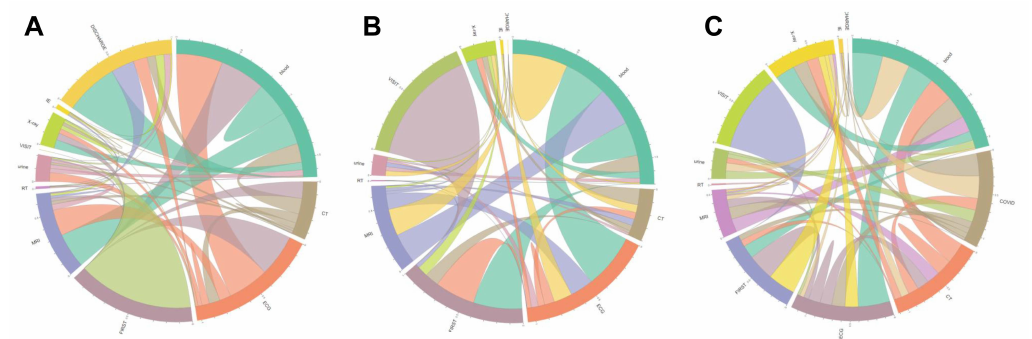
Figure 5. Chord diagram of overall ED patient process changes. The color indicates the next process that the patient moved to. The number refers to the rate of patients who underwent the process. ( A ) Phase 1, ( B ) Phase 2-CNTG, ( C ) Phase 2-CTG. Visit: time of the first visit to the ED; First: triage; IE: interventions and endoscopy; COVID-19: coronavirus disease; PCR: polymerase chain reaction; RT: nasal and sputum sample-based respiratory test; ECG: electrocardiography; Blood: blood sample-based laboratory tests; CT: computed tomography; Discharge: time when the discharge order or admission order was